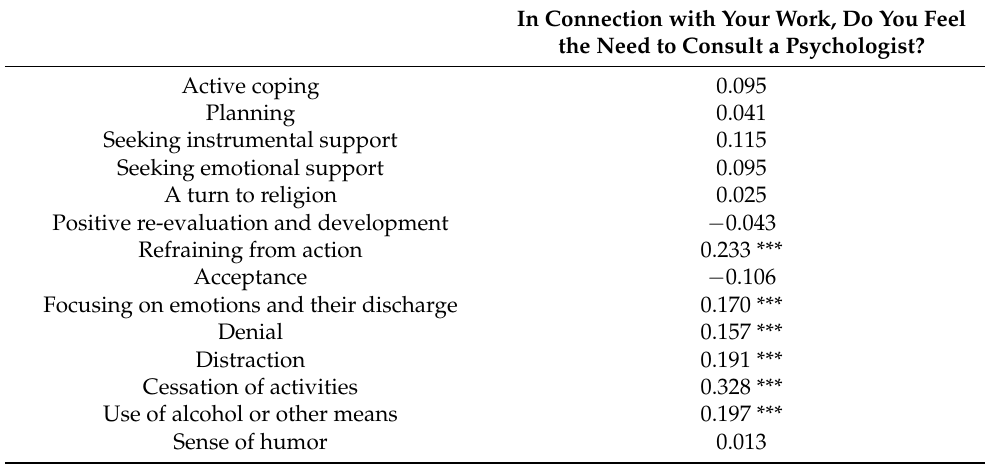
Table 8. Correlations between the MiniCOPE scores and the need to consult a psychologist.